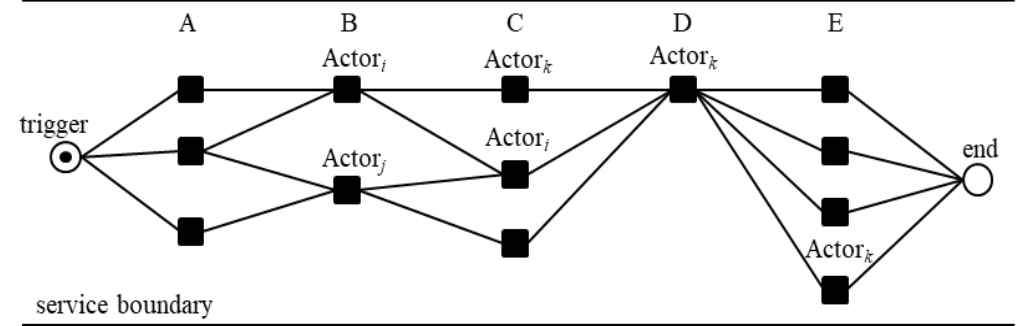
Figure 7. Service process and activity.